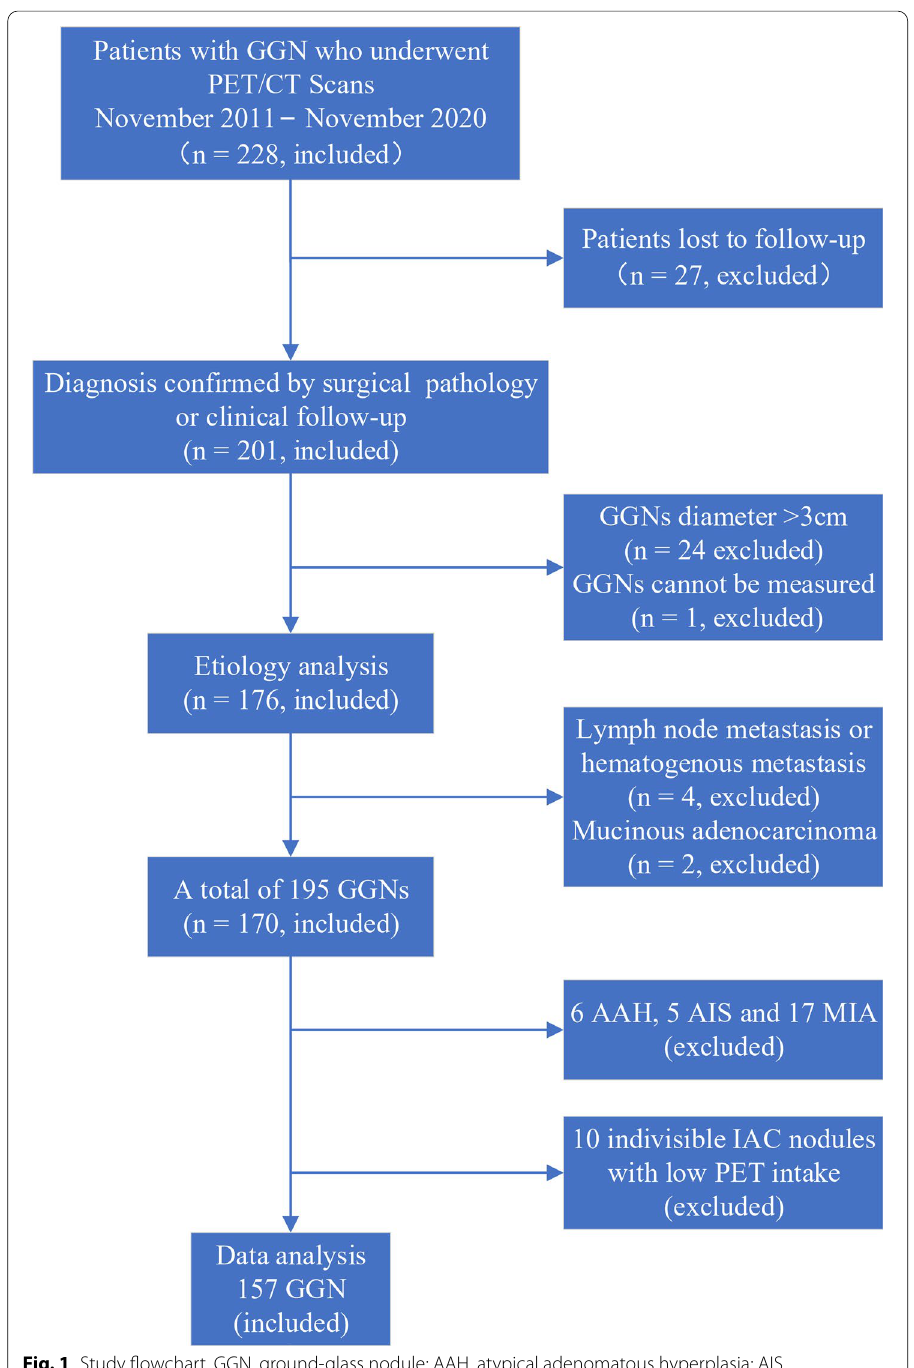
Fig. 1 Study flowchart. GGN, ground-glass nodule; AAH, atypical adenomatous hyperplasia; AIS, adenocarcinoma in situ; MIA, minimally invasive